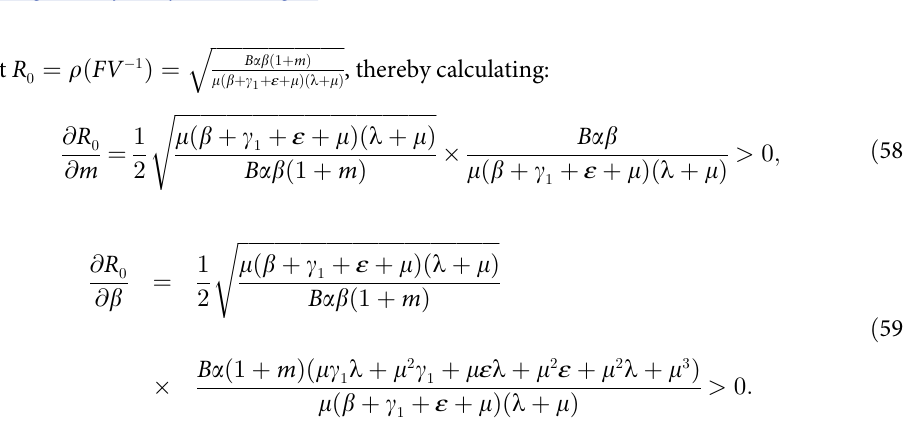
ffiffiffiffiffiffiffiffiffiffiffiffiffiffiffiffiffiffiffiffiffiffiffiffiffiffi B ab ð 1 þ m Þ m ð b þ g 1 þ ε þ m Þð l þ m